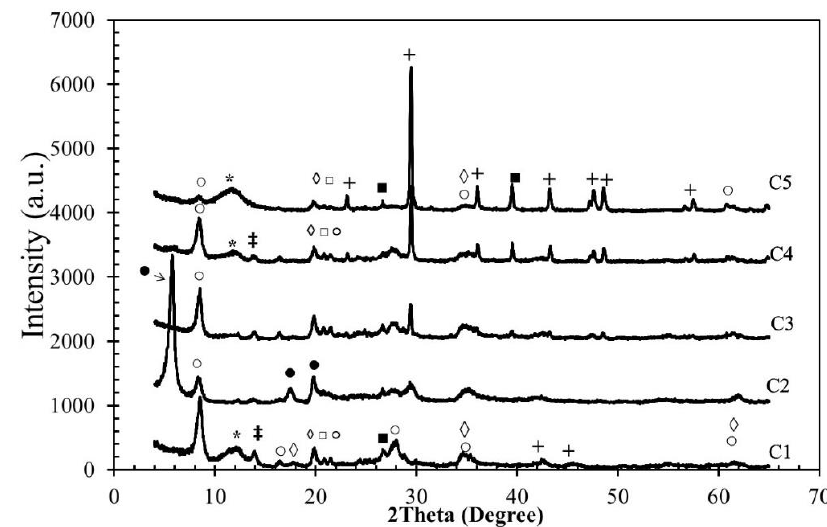
Figure 1. Powder X-ray patterns of in the study clays. Minerals denoted as (●) montmorillonite, ( ○ ) palygorskite, (+) calcite, ( ■ ) quartz, (◊) illite, (□) kaolinite, (‡) chlorite and (*) Al 2 Si 50 O 103 . Table 1. Mineralogy composition of the in the study clays from X-ray powder diffraction (XRD) analysis. Clay